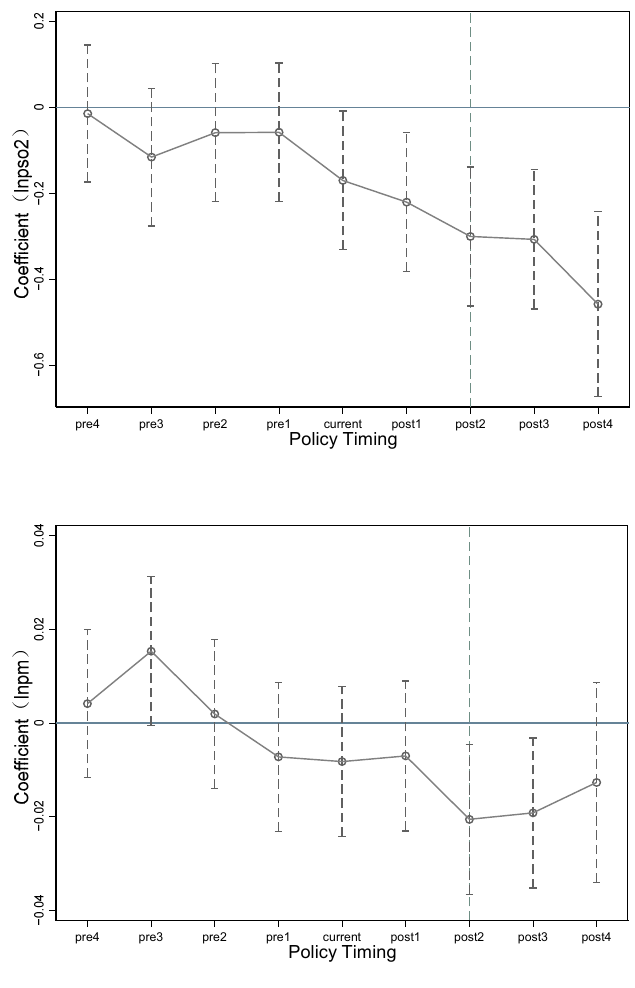
Figure 1. Parallel trend test.